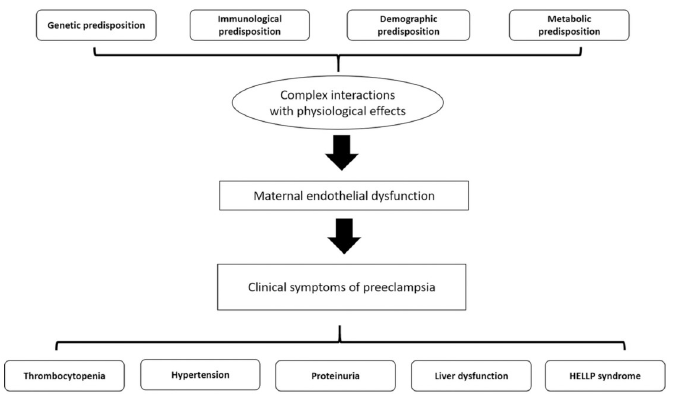
Fig 2. Summarized pathogenesis of